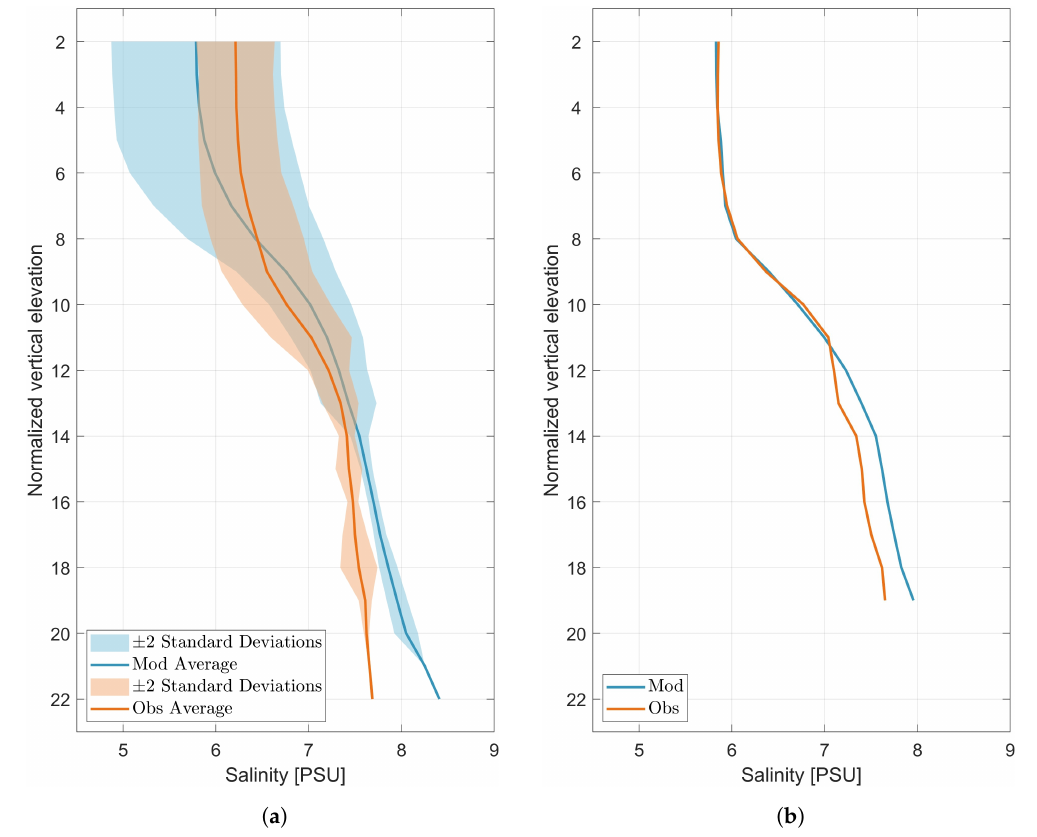
Figure 6. Salinity vertical profiles ( a ) from all stations ( b ) at station